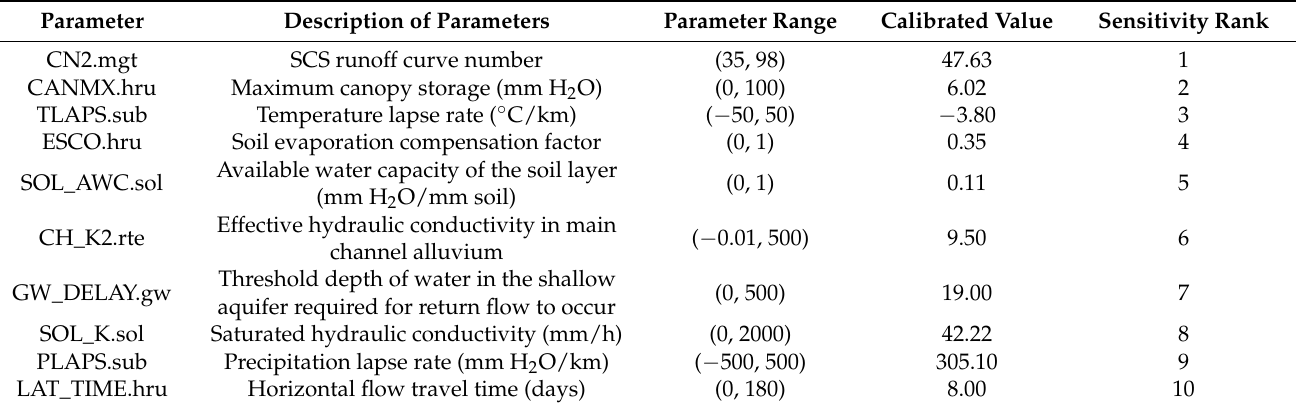
Table 5. List of sensitive parameters and their calibrated values for the swat